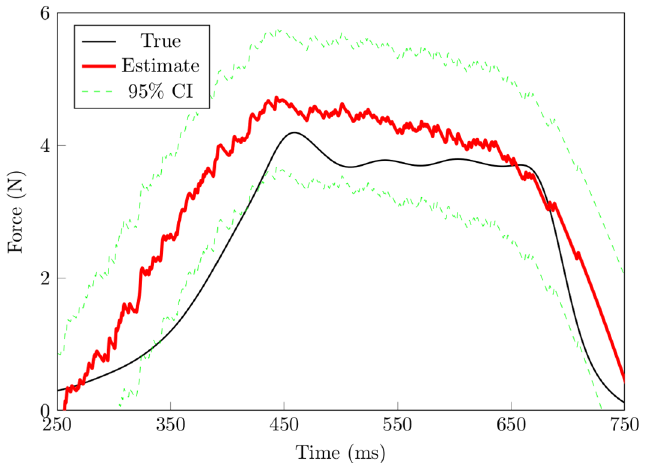
Fig 4. Decoding of entire force profile. We split the data into two sets of equal number of afferents. We used the first half of the data to encode and the other half to decode. Using this we have less spike trains for the decoding operation and may explain the relatively poor